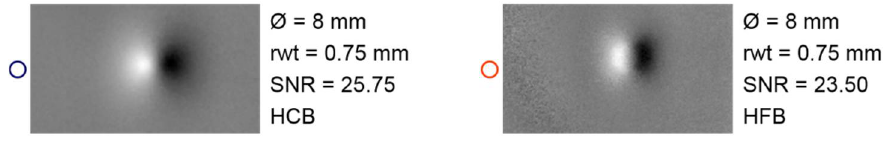
Figure 8. Comparison of the shearograms of blind holes with conical bottoms (HCB, ( left )) and blind holes with flat bottoms (HFB, ( right )) of diameter 8 mm and RWT 0.75 mm (see Figure 7).